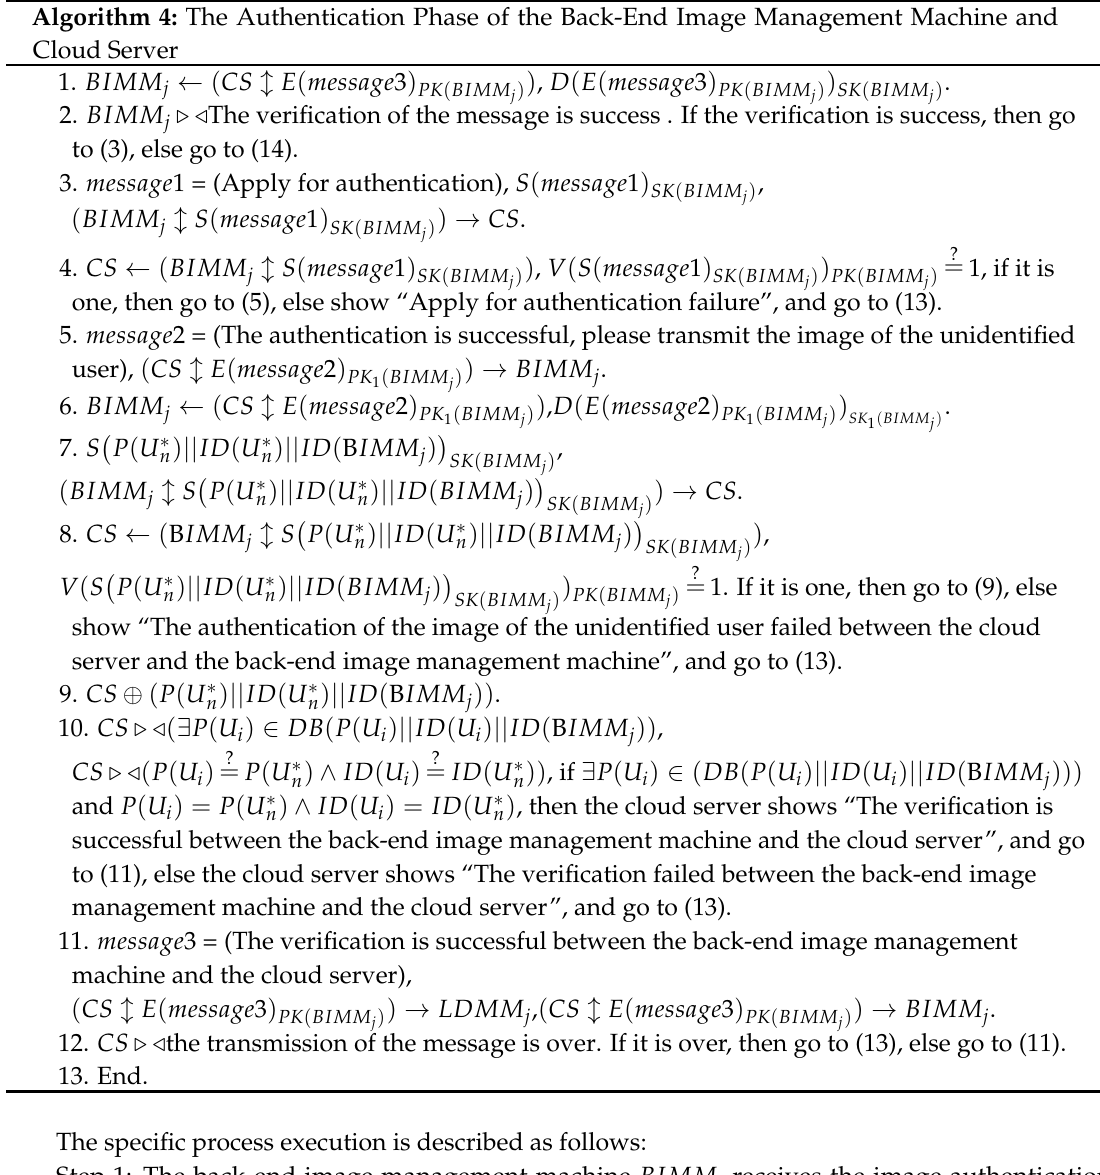
Algorithm 4: The Authentication Phase of the Back-End Image Management Machine and Cloud